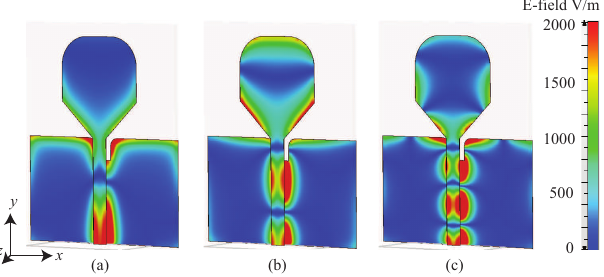
FIGURE 7: E-field distribution at: (a) 3 GHz. (b) 6 GHz. (c) 10 GHz.